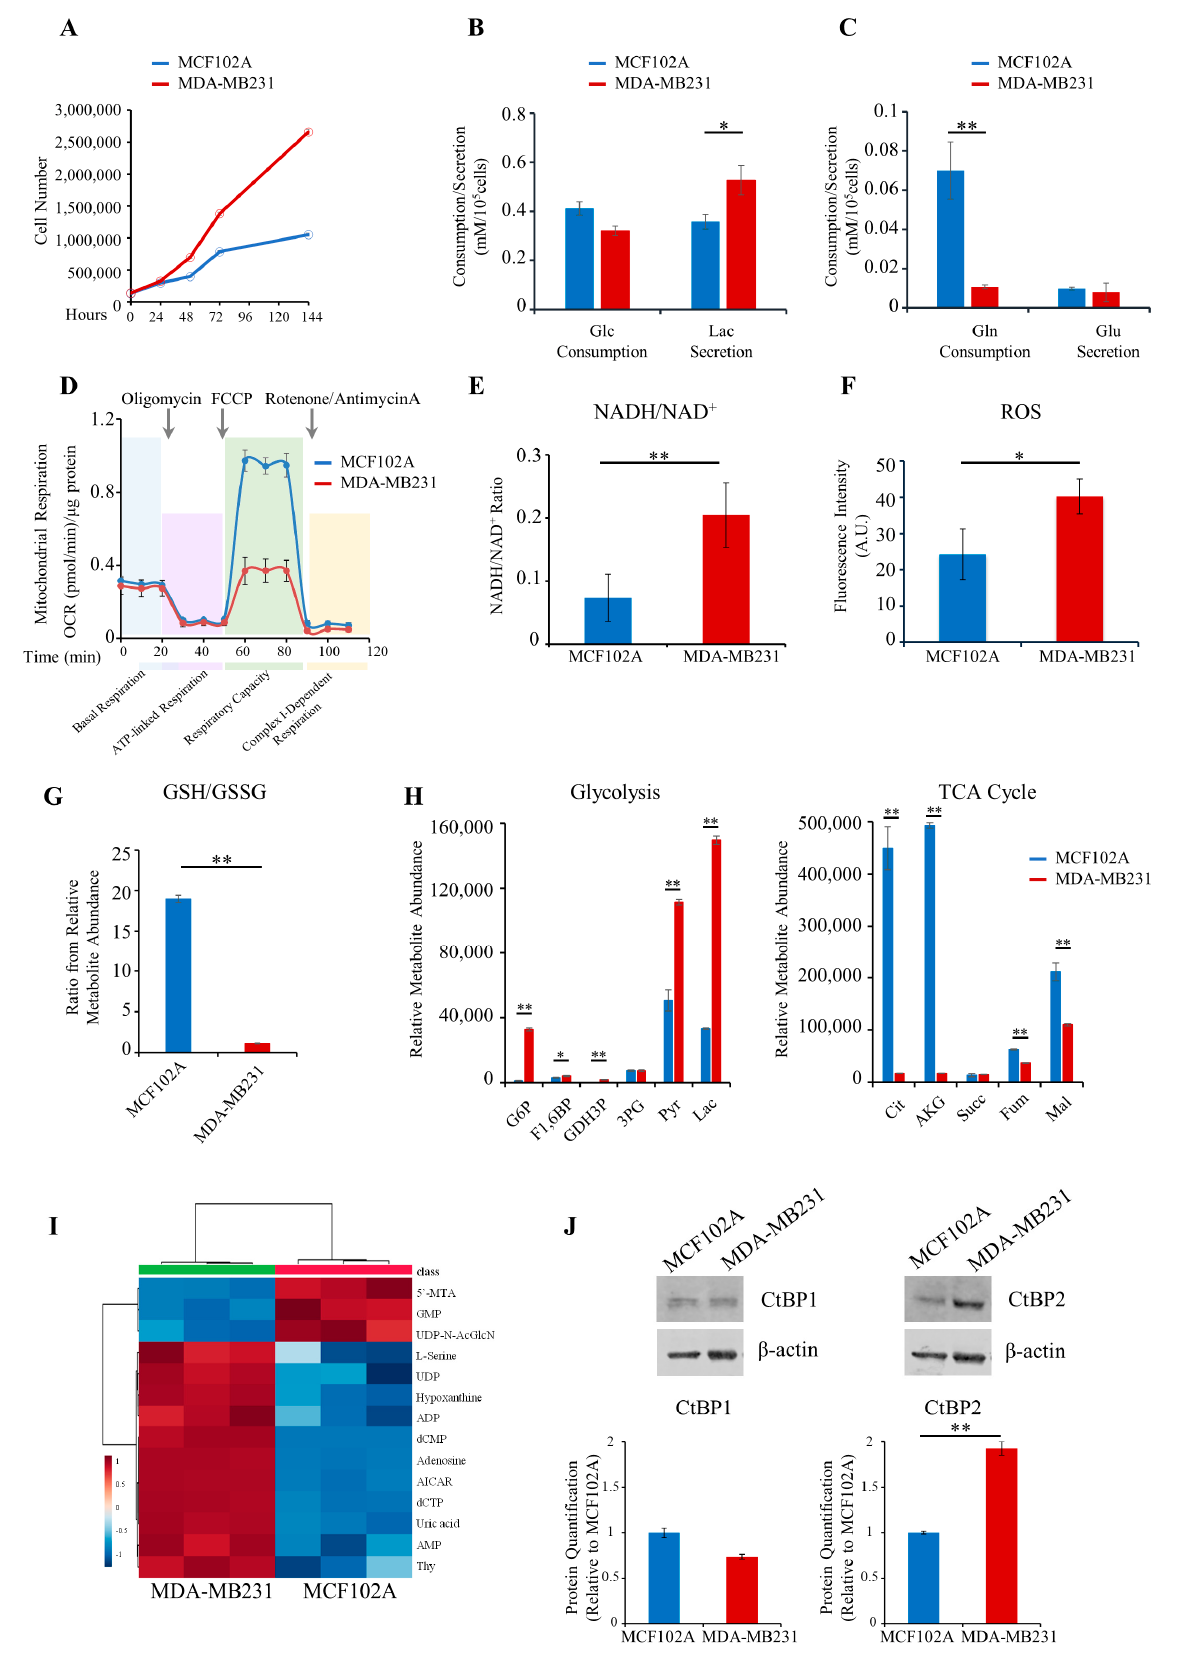
Figure 2. Metabolic phenotype characterization of the MDA-MB231 triple-negative breast cancer cell line. ( A ) Proliferation curves of MCF102A ( ▬ ) and MDA-MB231 ( ▬ ) cells. Cells were grown in 6-well plates in the appropriate growth medium. Cells were collected and counted at the indicated time points. ( B , C ) Extracellular uptake of Glc/Gln and secretion of